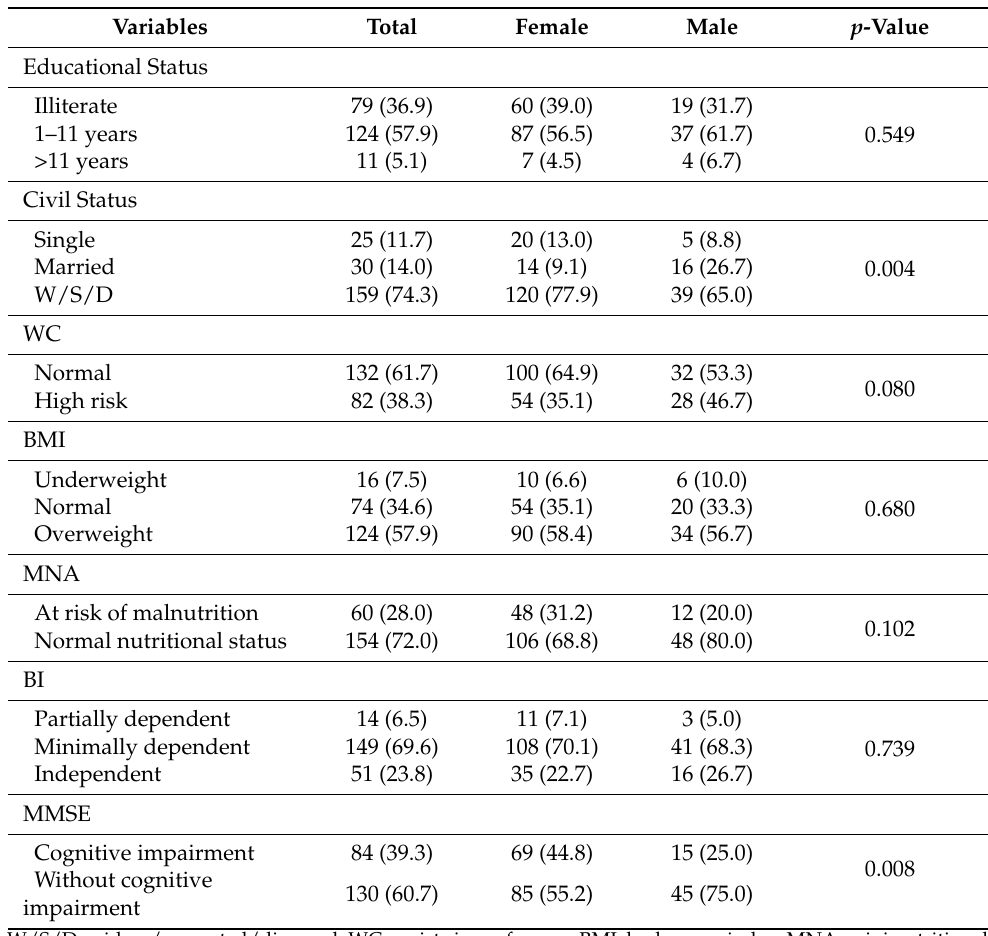
Table 1. Population demographics, nutritional, functional, and cognitive characteristics by